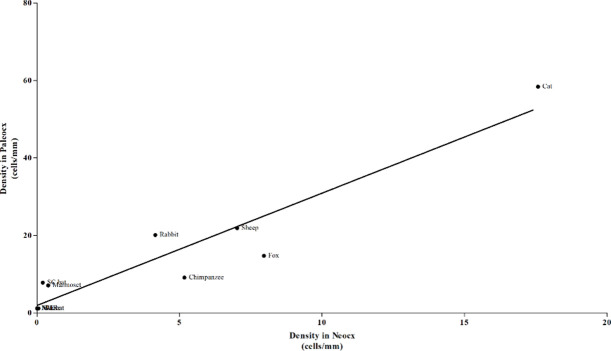
Correlation study between DCX+ cell density in paleo- and neo-cortex.There is a highly significant correlation (***). By varying the neocortex also paleocortex varies (adult ages are grouped).